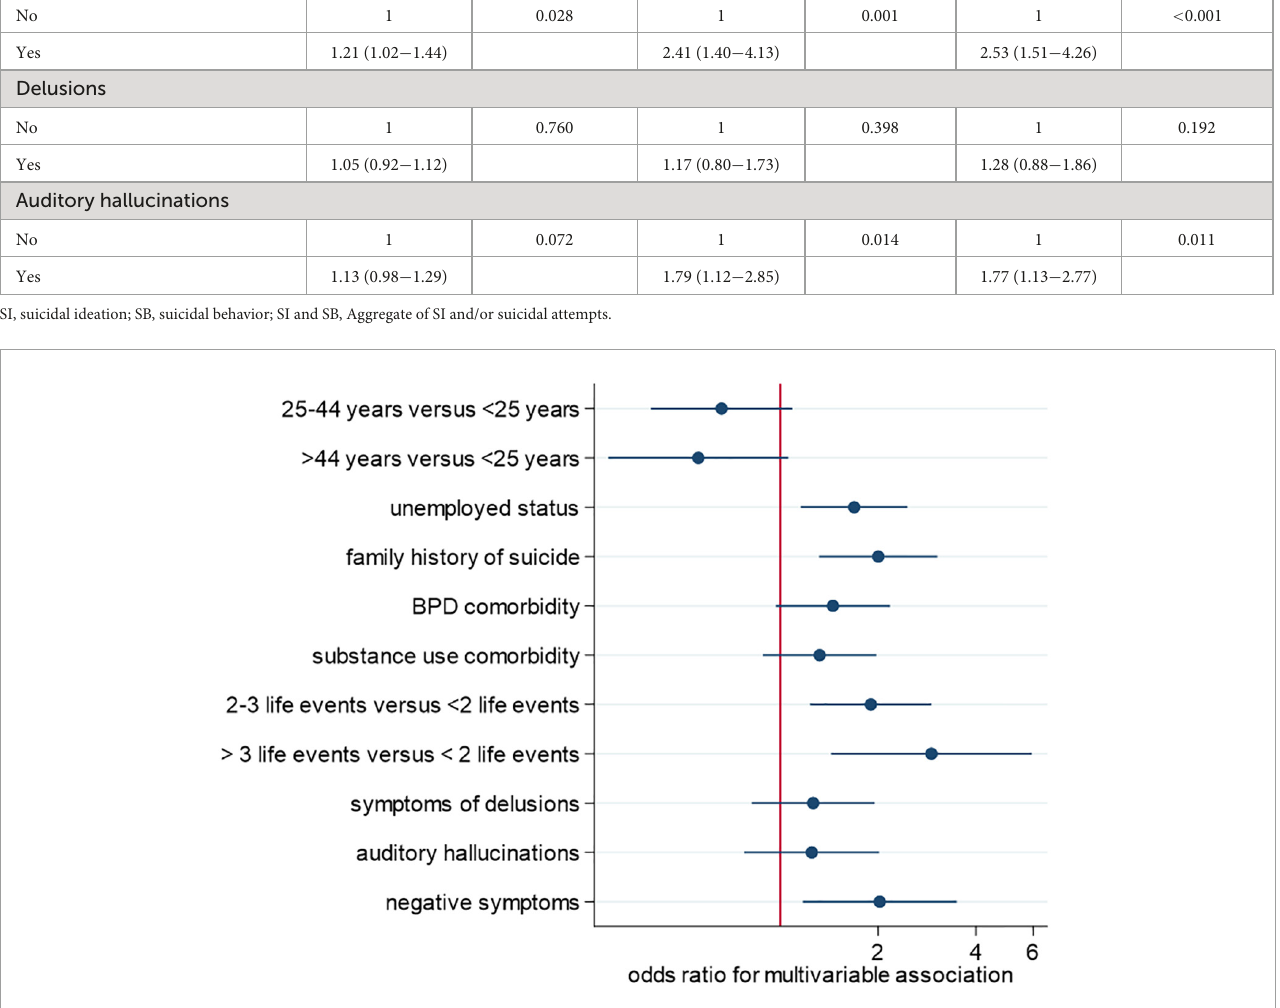
FIGURE2 Multivariate factors for suicidal